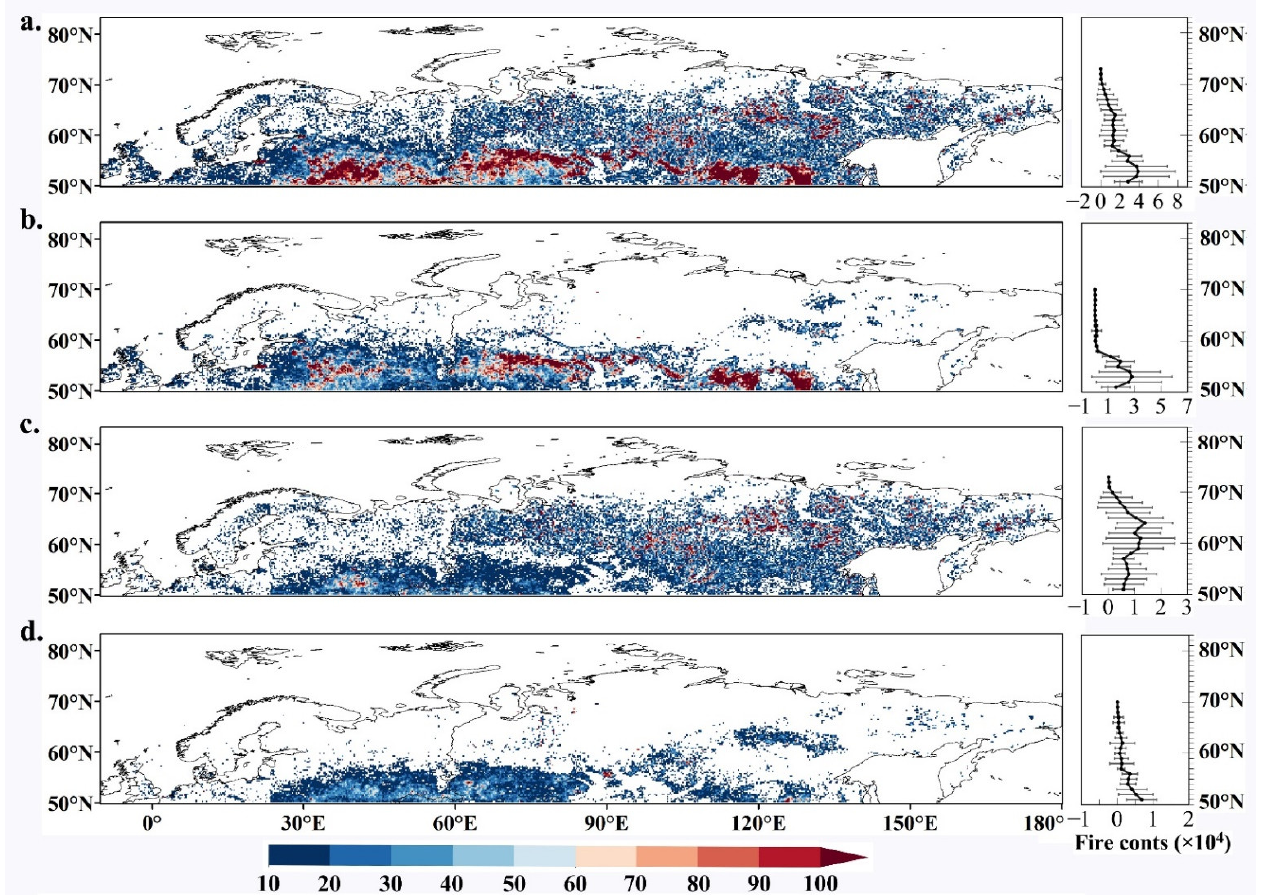
Figure 3. Observed multi-year mean active fire counts in NEA from 2003 to 2020. Panel ( a – d ) show the spatial distribution of multi-year mean active fire counts for annual ( a ), spring ( b ), summer ( c ), and autumn ( d ), respectively.